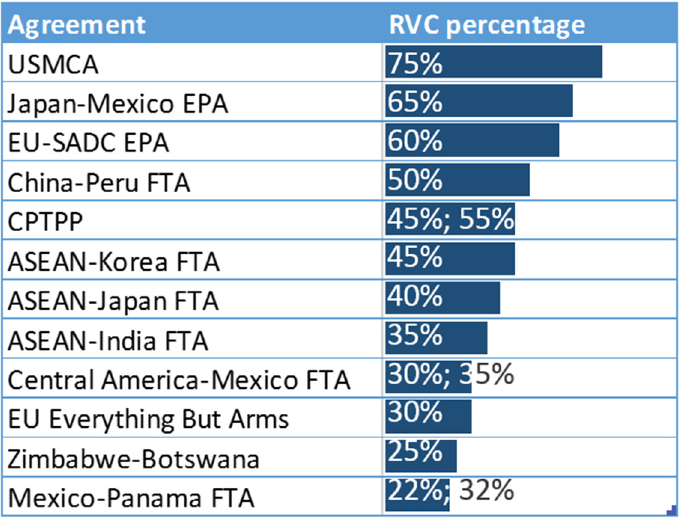
Figure 1. RVC percentages for cars (HS 8703.23 with gasoline engine) in a selection of 12 PTAs. Note: When two percentages are presented, each percentage is defined by a distinct calculation method.